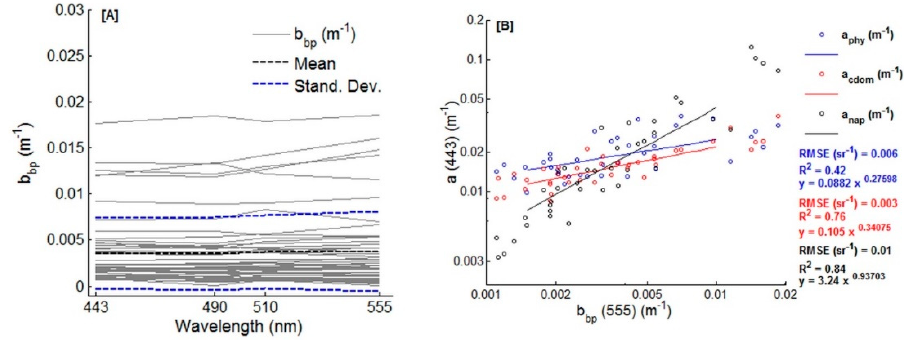
Figure 7. Particulate backscattering coefficient ( b bp ) spectra for each station, mean and standard deviation (Number of samples = 52) ( A ). The b bp at 555 nm versus phytoplankton absorption ( a phy ) at 443 nm, Coloured dissolved organic matter (CDOM) absorption ( a cdom ) at 443 nm and non-algal particles (NAP) absorption ( a nap ) at 443 nm with their mean square error, coefficient of determination (R 2 ) and the power law fit for the 51 stations sampled in ELNC ( B ) (axes in log10).